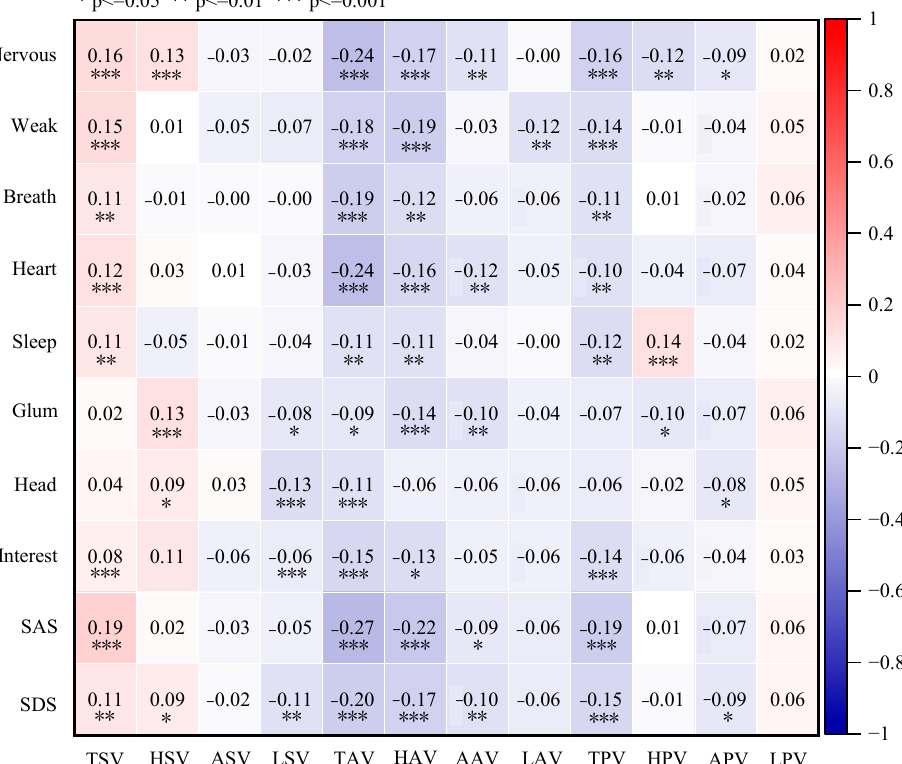
Figure 7. Results of the correlation analysis between the environmental perception and psychological state.